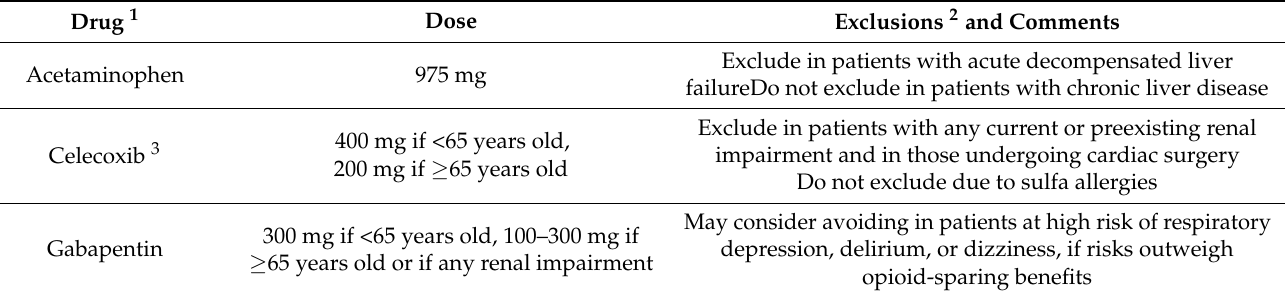
Table 4. Example Preemptive Analgesia